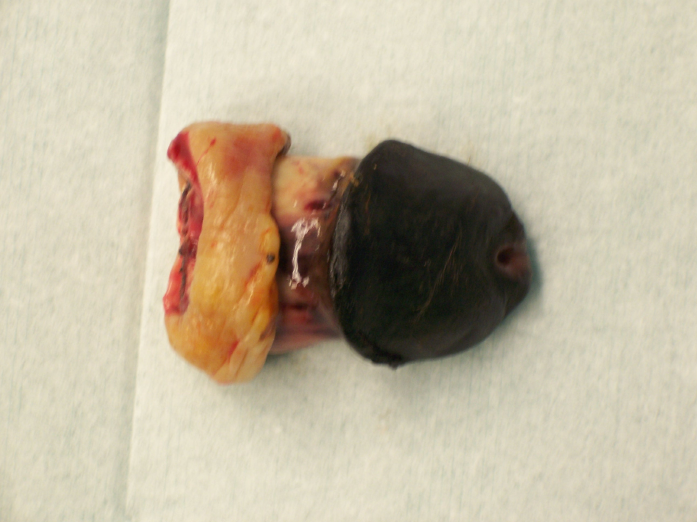
FIGURE 3. Partial penectomy specimen exhibiting dry gangrene of the glans and distal